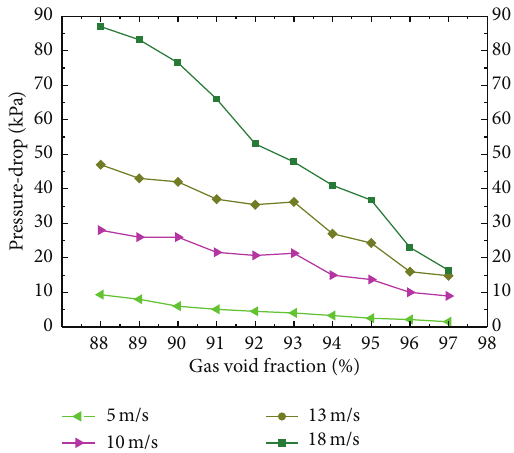
Figure 4: The influence of the inlet velocity on pressure-drop under different gas void fractions.